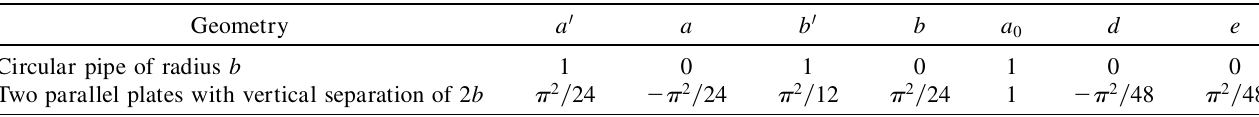
TABLE I. Expansion coefficients for Eq.